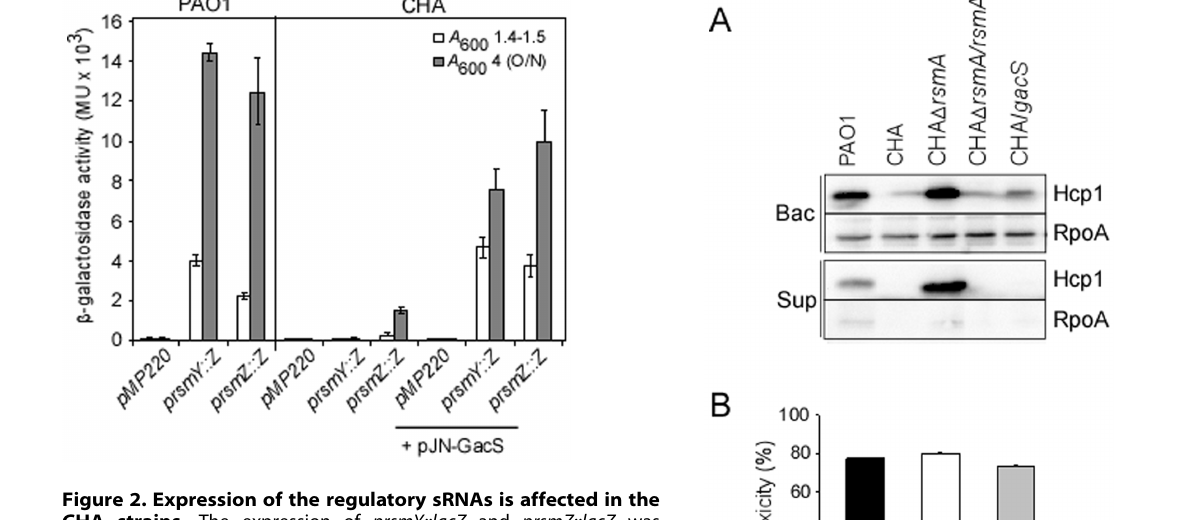
Figure 2. Expression of the regulatory sRNAs is affected in the CHA strains. The expression of prsmY::lacZ and prsmZ::lacZ was measured in PAO1 and CHA at two different A 600 . When indicated, the pJN-GacS plasmid was introduced. The plasmid pMP220 is the promoter-free lacZ plasmid used as a control. The reported values for enzyme activities are the average of at least two independent experiments performed in triplicate. The bars indicate the standard deviations. O/N: overnight culture.